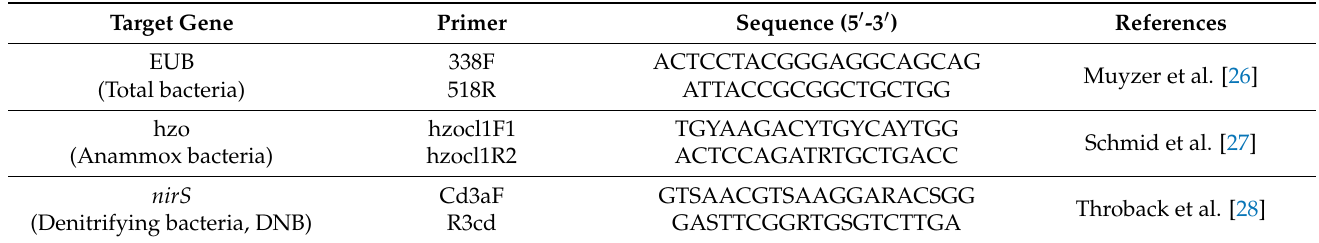
Table 3. List of PCR primers for the amplification.